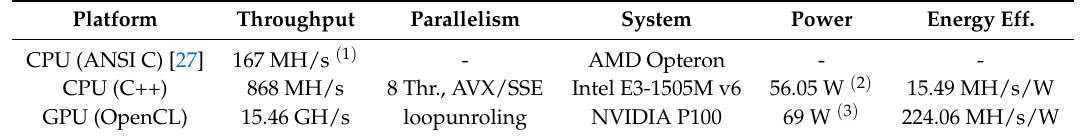
Table 2. Overview of CPU and GPU